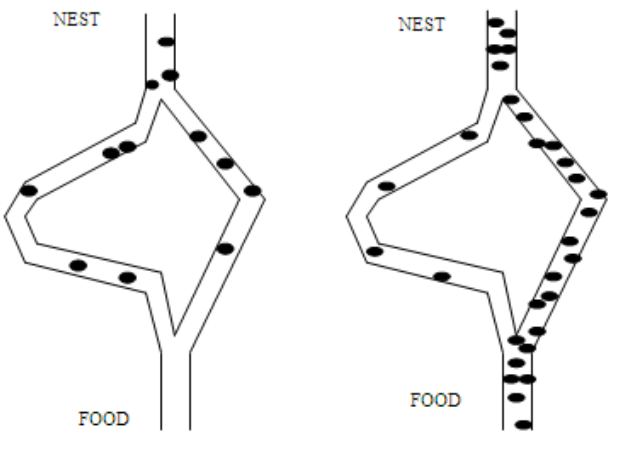
Figure 3. The behavior of real ant